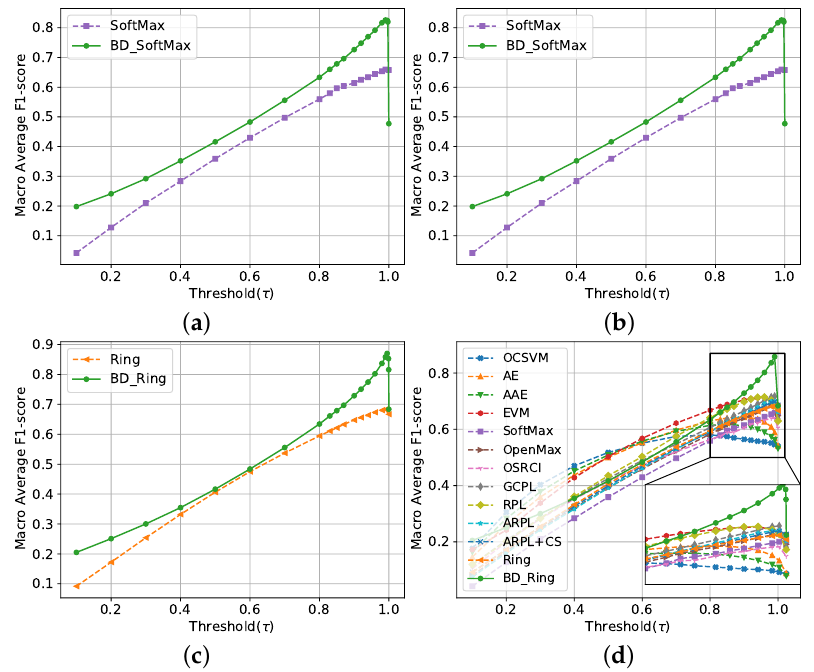
Figure 8. This figure shows that the performance of the proposed method varies with the threshold τ . ( a ) SoftMax; ( b ) GCPL; ( c ) Ring; ( d ) All